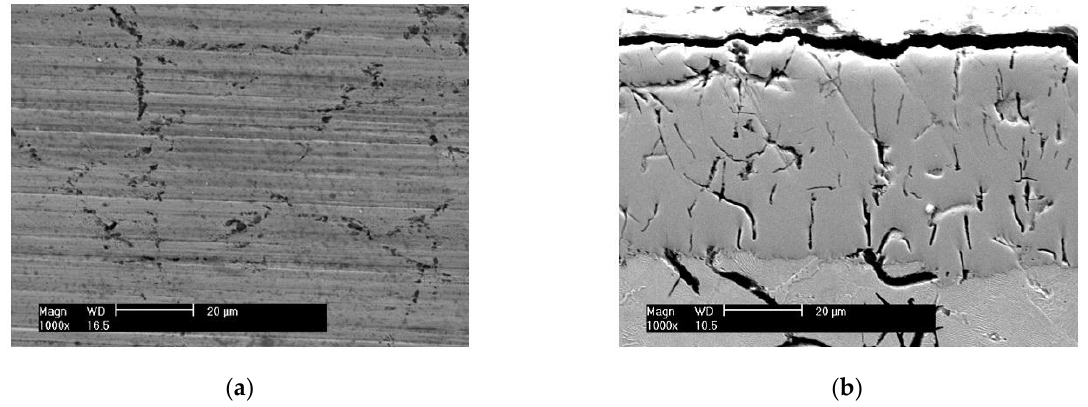
Figure 2. Surface ( a ) and cross-section ( b ) morphology of the piston ring with the CKS coating.